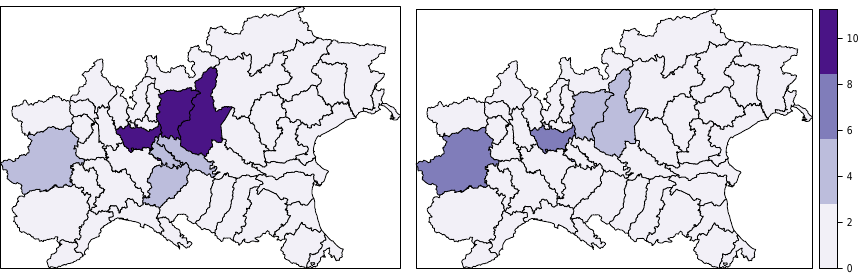
Figure 2. Detecting cases relative risk specific of the province ζ i = exp ( v i + ν i ) in the disease mapping models. Left panel : pre-lockdown model. Right panel : post-lockdown